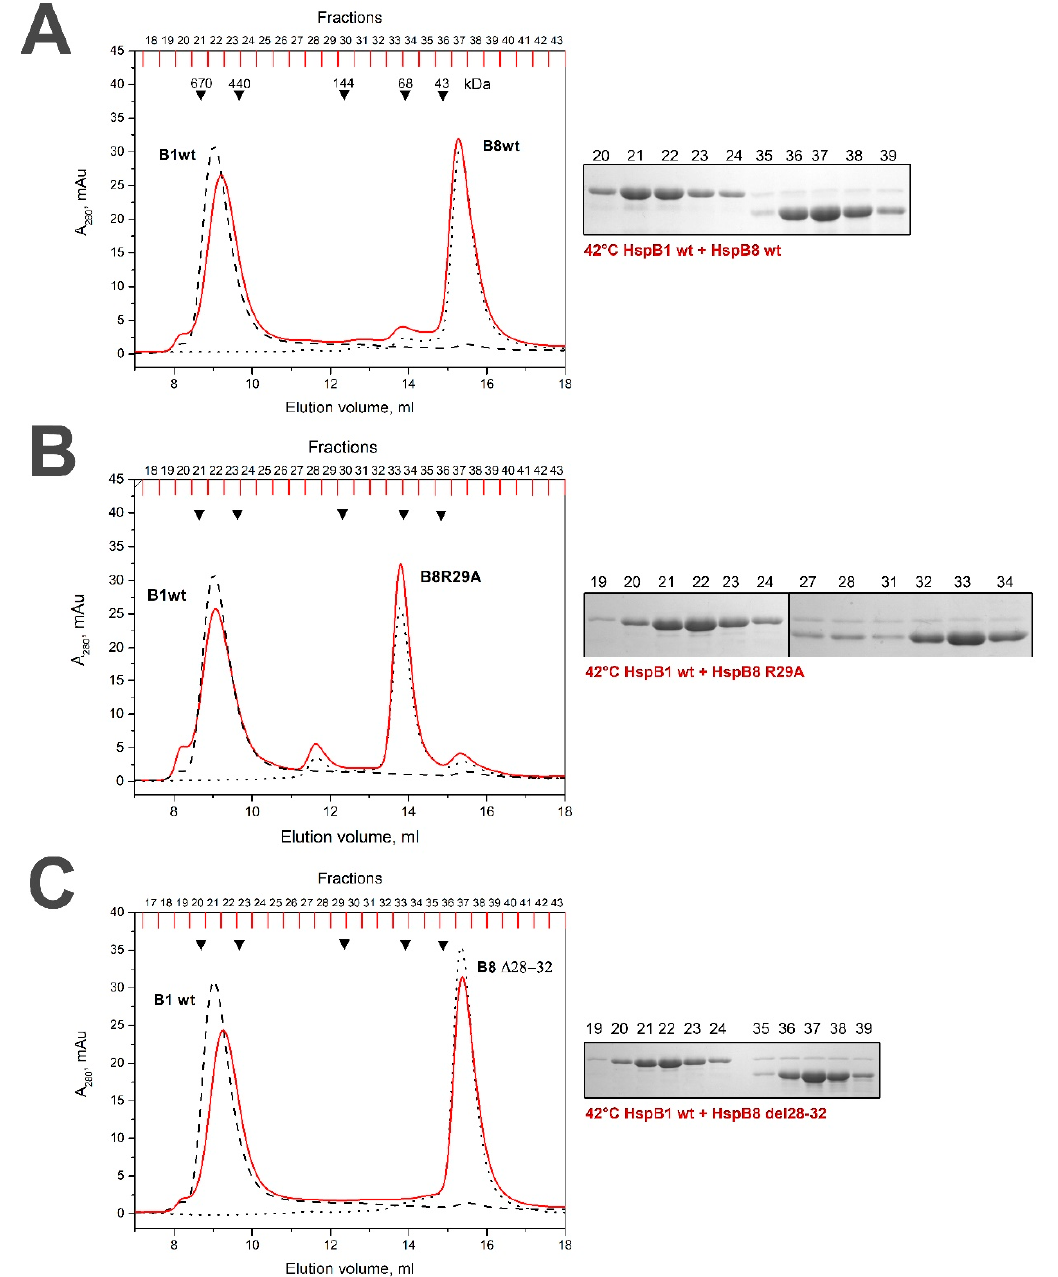
Figure 7. Size exclusion chromatography of the WT HspB1 and the WT HspB8 ( A ) or its R / A ( B ) or ∆ ( C ) mutants. The elution profile of HspB8 and its mutants is shown as a black dotted line and that of isolated HspB1 as a black dashed line. The elution profile of the mixture of HspB1 and HspB8 species preincubated at elevated temperature is shown as a solid red line. The protein compositions of fractions obtained after chromatography of HspB1 / HspB8 mixture preincubated at high temperature are presented on inserts. The numbers above tracks correspond to the fractions number. Apparent molecular weights are indicated by arrows.